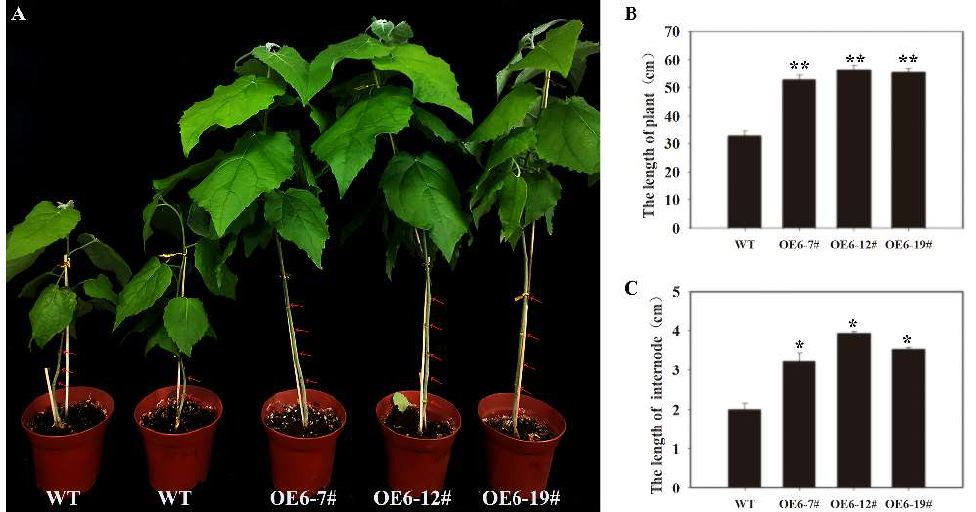
Figure 8. The phenotype analysis of PtoNF-YC6 transgenic P. tomentosa . ( A ) PtoNF-YC6 transgenic P. tomentosa plants with different growth phenotype. ( B ) Plant height analysis of PtoNF-YC6 trans- genic P. tomentosa plants. ( C ) Internode statistical analysis of PtoNF-YC6 transgenic P. tomentosa plants. * ( p < 0.05) and ** ( p < 0.01) indicate significant differences. Figure A red arrows represent internodes.